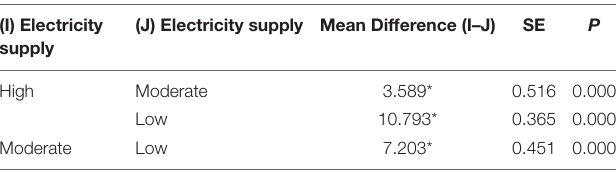
TABLE 8 | Fisher’s LSD test of multiple comparisons of ICT deployment based on the degree of electricity supplied to academic staff in public